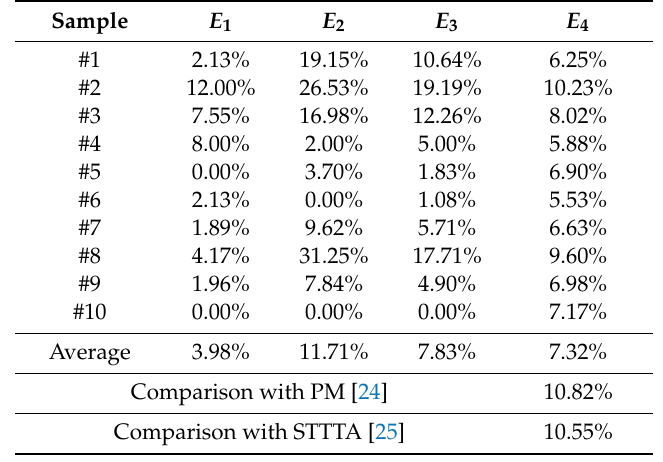
Table 7. Detection error rates of CSM compared with the reference method with 10 samples under variable speed walking.